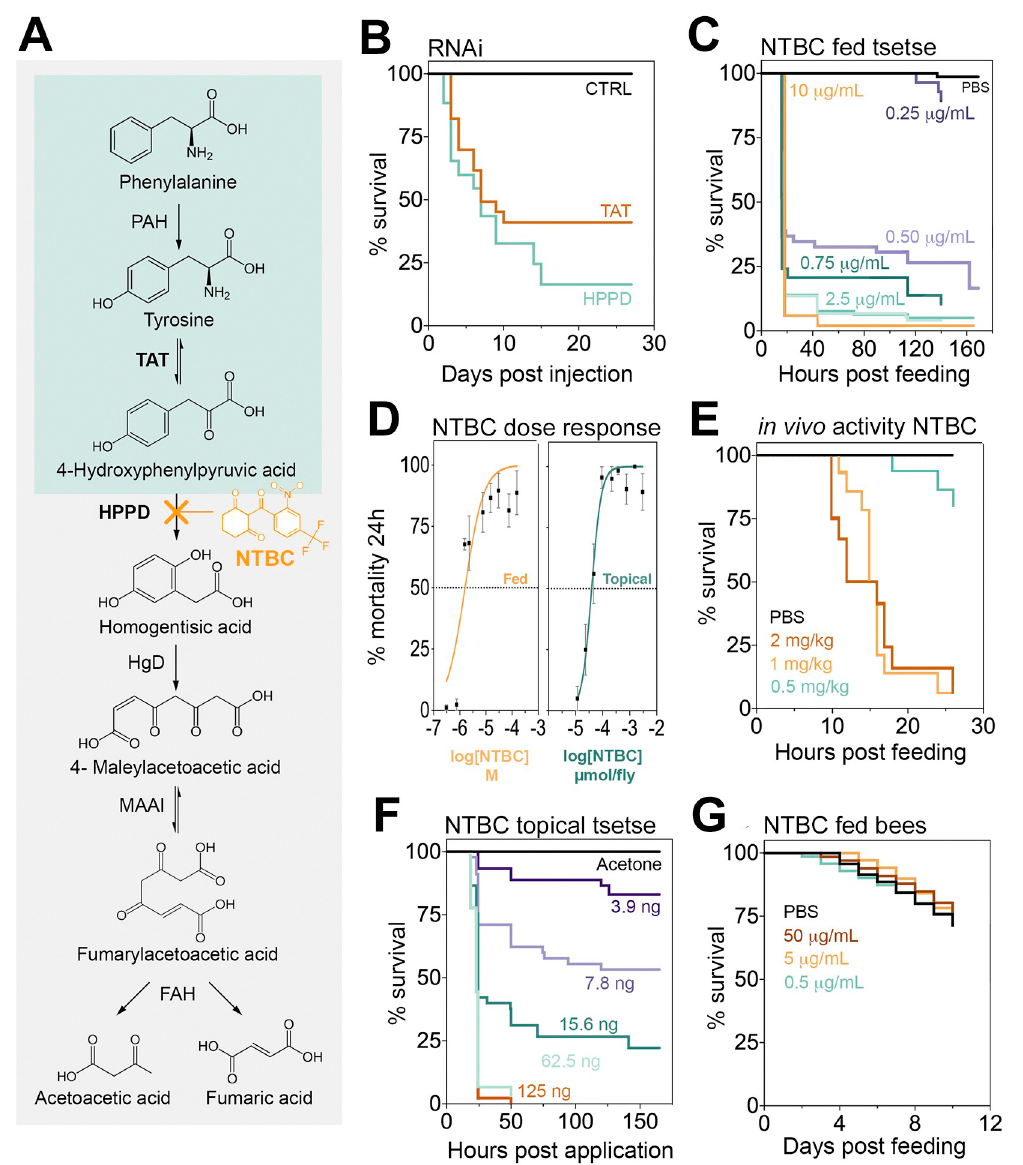
Fig 1. Inhibiting tyrosine catabolism is lethal for tsetse, but not for bees. (A) Tyrosine catabolism pathway. (B) Survival of Glossina morsitans morsitans when injected with dsRNA to knockdown TAT or HPPD. Two independent experiments were performed, each with n = 10–13, 12–16, and 12–14 for dsGFP (CTRL), dsTAT, and dsHPPD, respectively. Five insects from each group were dissected three days after a bloodmeal (PBM) to assess gene knockdown efficiency (S2 Fig). (C) Survival of G . m . morsitans fed with horse blood supplemented with NTBC or PBS (Control. 9:1; v/v). Three to six independent experiments were performed for different doses, each with n = 10–25 insects. The total number of flies (male and female) used was 914 (All doses applied are shown in S3B Fig). (D) Dose-response curves for G . m . morsitans survival 24 hours PBM: NTBC feeding and topical application assays (mean ± SEM). (E) Male Glossina pallidipes survival after feeding on PBS- or NTBC-treated rats. Doses are presented as mg of NTBC per kg of rat body weight. Three independent experiments were performed per dose, each with n = 12– 15 flies. The total number of male flies used was 86. (F) Survival of NTBC-treated (topically) G . m . morsitans after a bloodmeal. Three independent experiments were performed for each dose, each with n = 10–20 insects. The total number of male flies used was 449. (G) Bee survival when maintained on a 50% sugar solution supplemented with NTBC (or PBS) and pollen. Two independent experiments were performed, each with n = 25 insects. The total number of bees used was 200. The underlying data for this figure can be found in S1 Data. CTRL, control; dsGFP, double-stranded green fluorescence protein; dsRNA, double- stranded RNA; FAH, fumarylacetoacetase; HgD, homogentisate 1,2-dioxygenase; HPPD, 4-hydroxyphenylpyruvate dioxygenase; MAAI, maleylacetoacetate isomerase; NTBC, nitisinone; PAH, phenylalanine hydroxylase; PBM, post-blood meal; TAT, tyrosine aminotransferase.